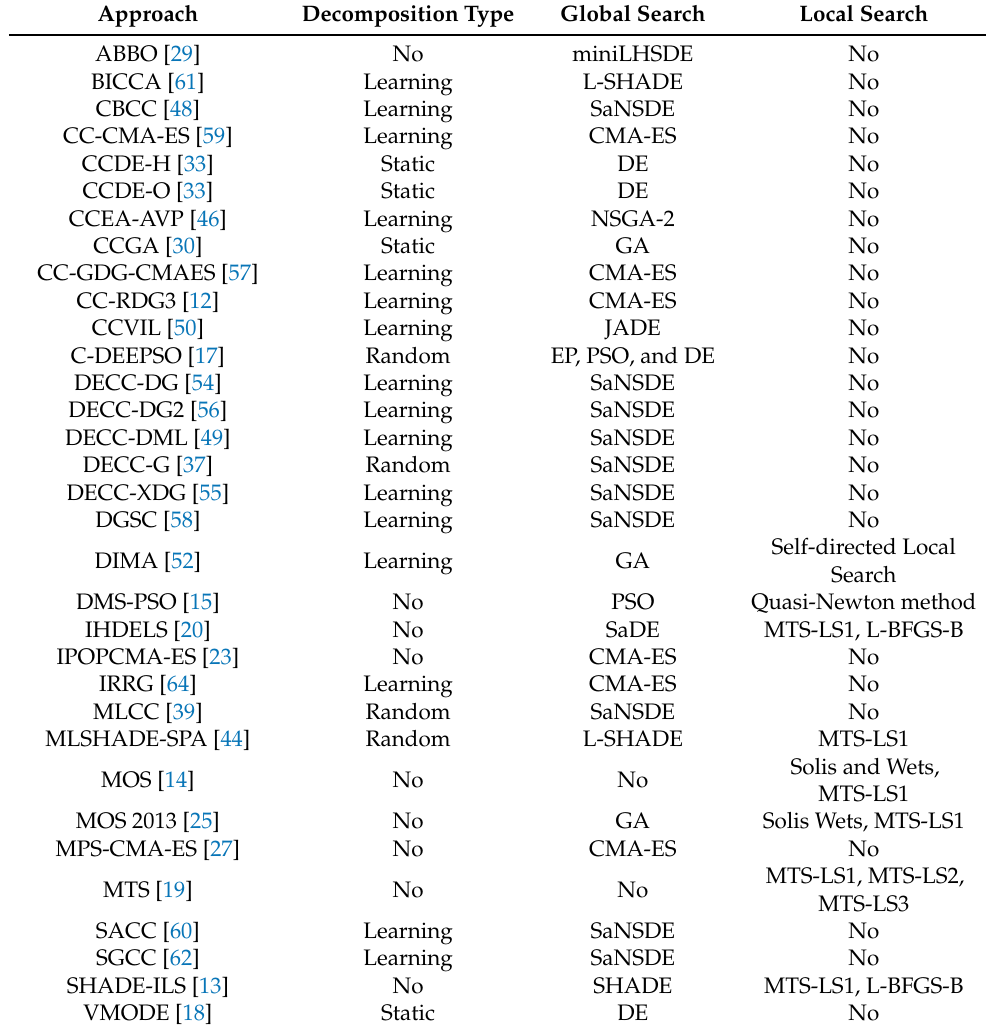
Table 1. The summary of the reviewed LSGO approaches.